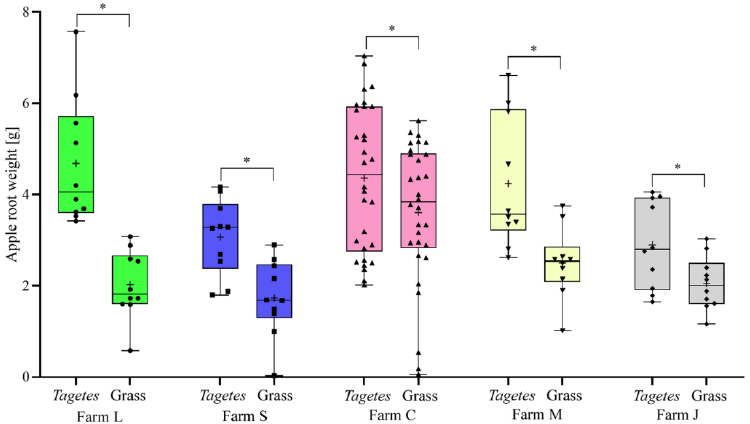
Figure 3. Root fresh mass of apple plantlets in response to inocula of nematodes recovered from ARD soils that were pre-cultured with Tagetes or grass before replanting apple. Crosses indicate means; boxes indicate medians and quartiles; stars indicate significant treatment effects as revealed by the respective contrasts in a generalized linear mixed model. Shoot fresh mass and shoot length were significantly larger when plants were inocu- lated with nematodes from the Tagetes treated ARD plots compared to inoculation of nem- atodes from the grass treated ARD plots ( p = 0.0001, Table 5). The factor FARM had a significant effect on shoot fresh mass ( p = 0.0089), but not on shoot length ( p = 0.33). The respective interactions of FARM and TREATMENT were not significant. Contrasts re- vealed for each farm a significant Tagetes effect on shoot fresh mass ( p < 0.006), while the difference between treatments was most pronounced for farm L, followed by farm S (Table 5). Table 5. Vegetative growth of apple M26 plants in pots inoculated with nematodes extracted from ARD soils pre-cultured with Tagetes or grass.